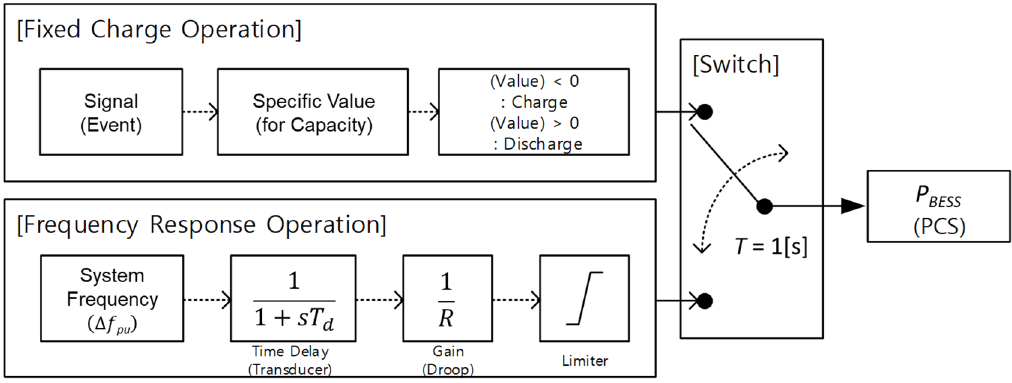
Figure 4. The proposed BESS hybrid control block .